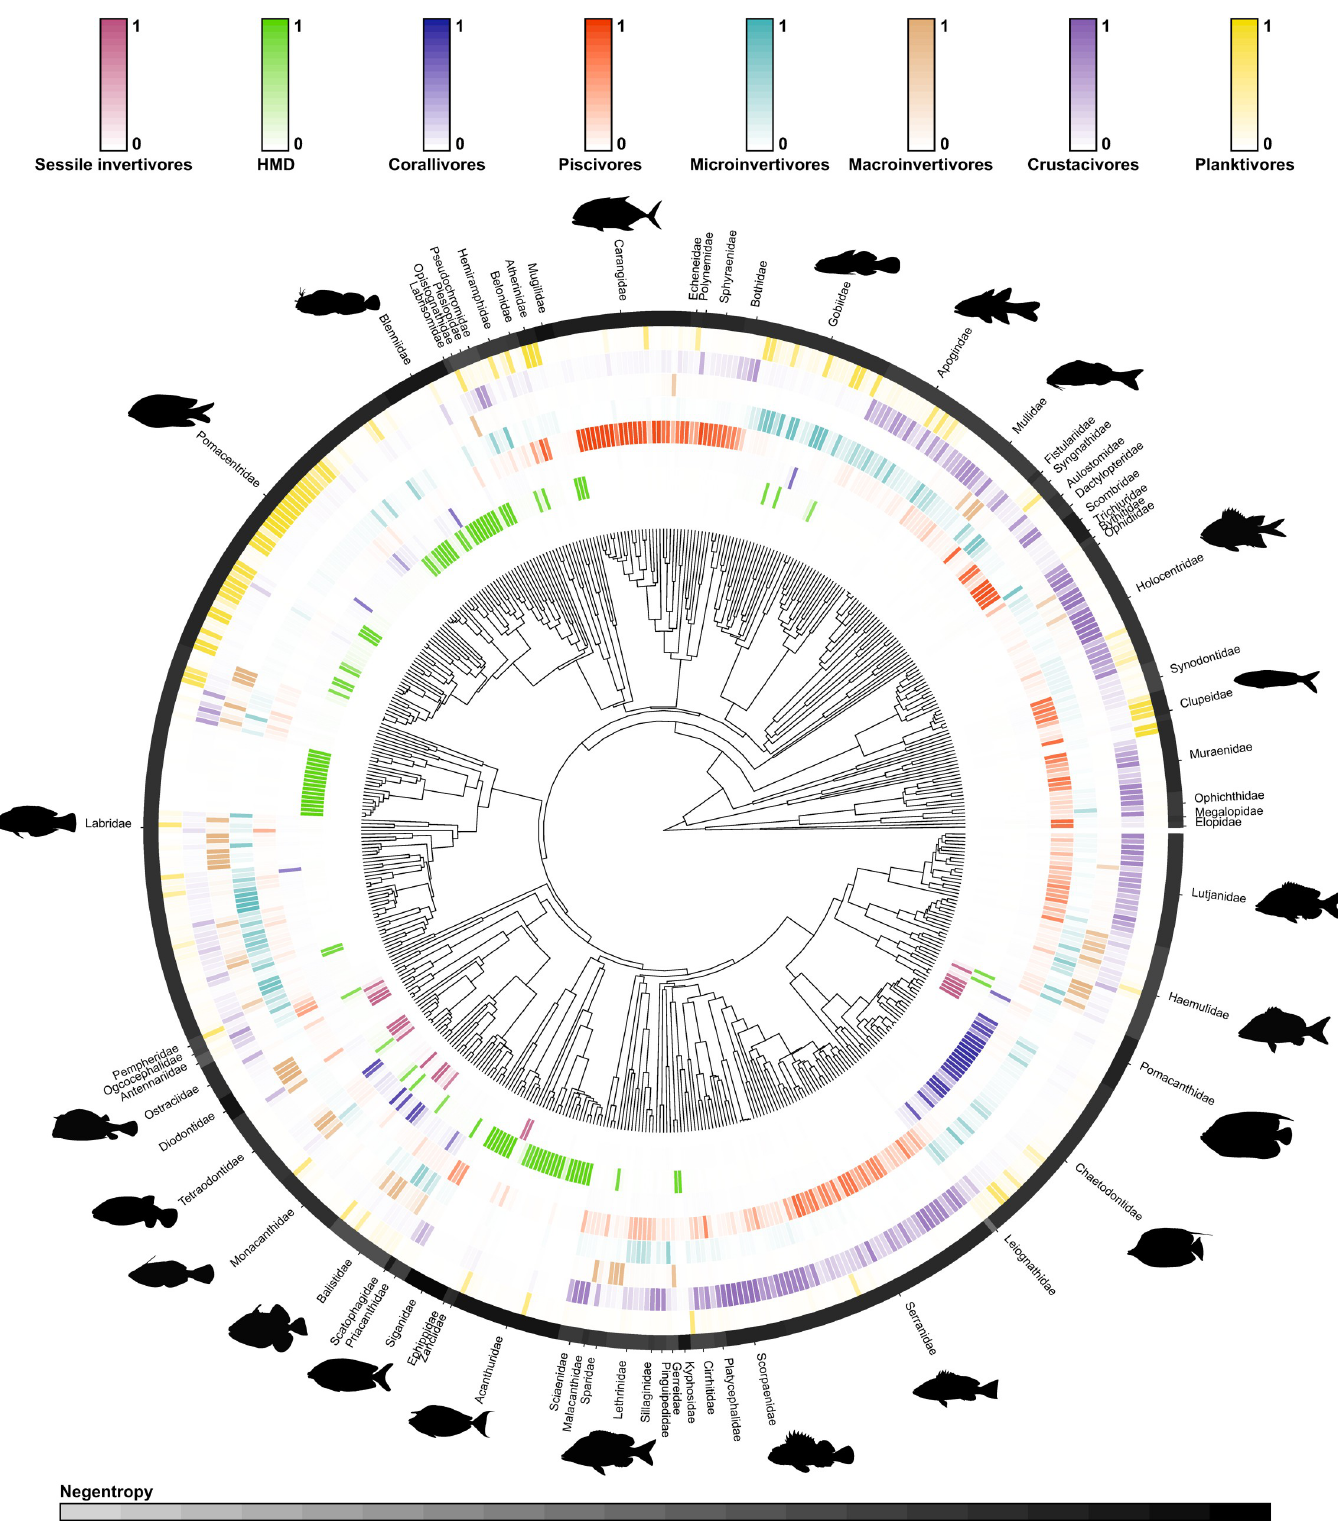
Fig 4. Phylogenetic tree of 535 reef fish species with fitted trophic guild assignments based on empirical dietary data. Trophic guild predictions were made with a Bayesian multinomial phylogenetic regression. The probability of trophic guild assignments for each species is visualized with color scales (depicted above the